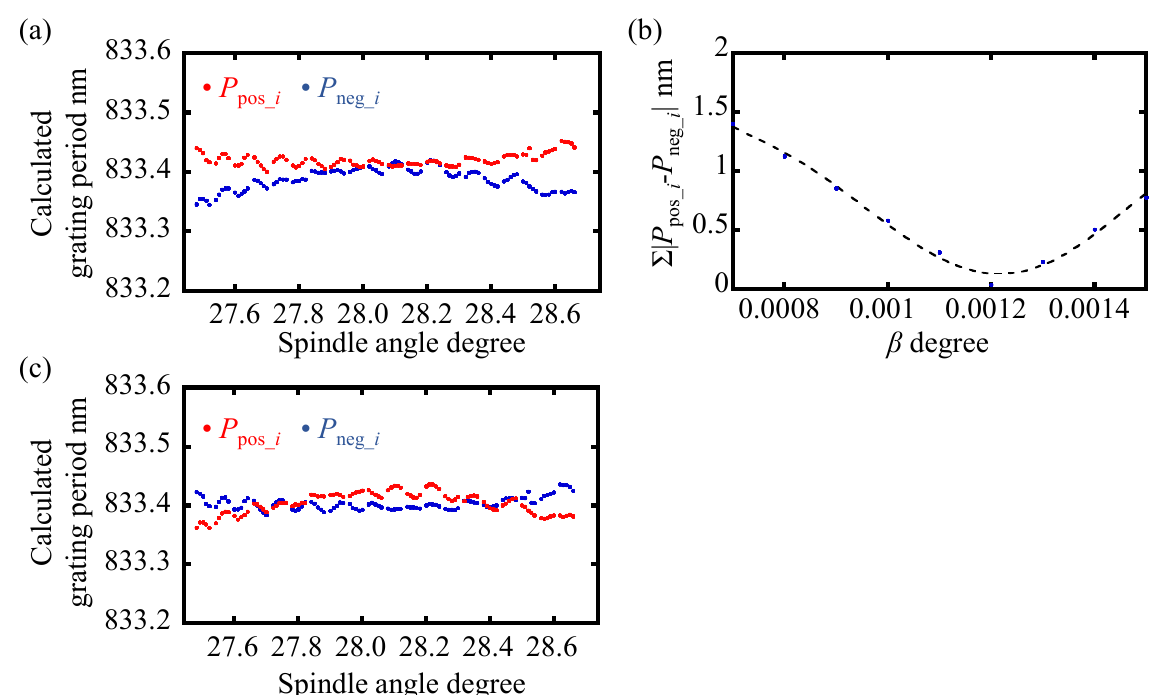
Figure 11. Grating pitch calculated from the peak wavelength obtained at each angular position of the scale grating: ( a ) Grating pitches P pos_ i and P neg_ i calculated by using the positive and negative first-order diffracted beams without the compensation of β ( β = 0); ( b ) Variation of Σ | P pos_ i − P neg_ i | with the change in β ; ( c ) P pos_ i and P neg_ i after the compensation of β ( β = 4.363 arc-seconds).